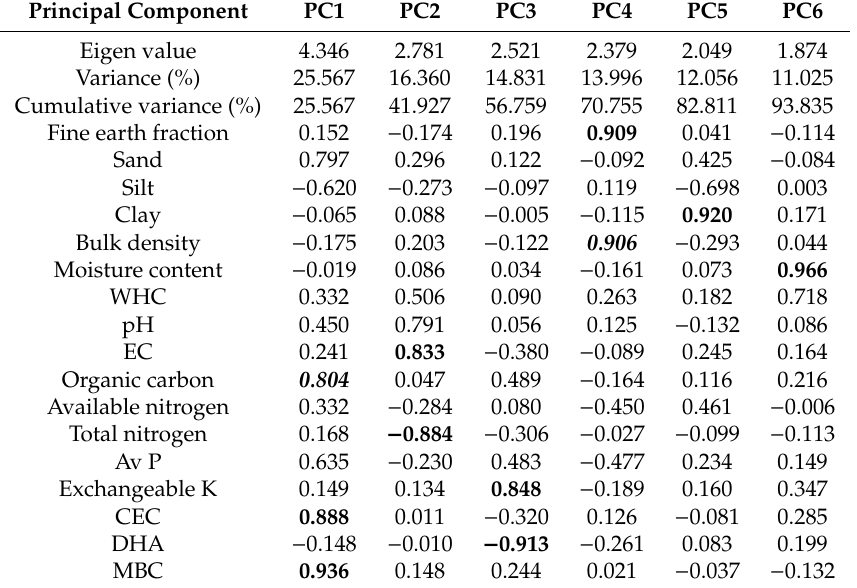
Boldface factors correspond to the parameters included in the index, boldface italic factors correspond to the highly loaded